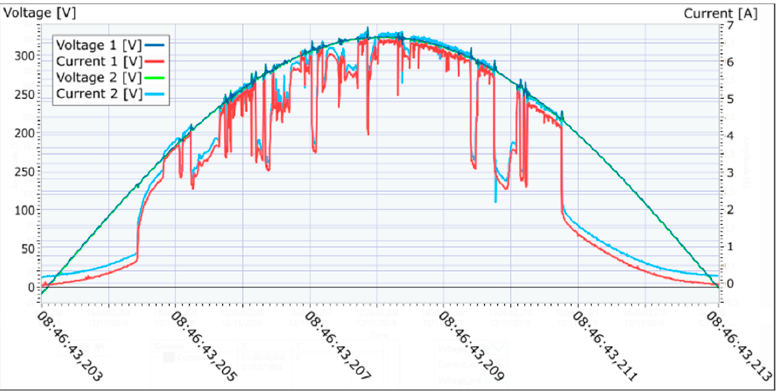
Figure 6. Deformation of the arc (using the Bourns 2049-07 surge arrester).